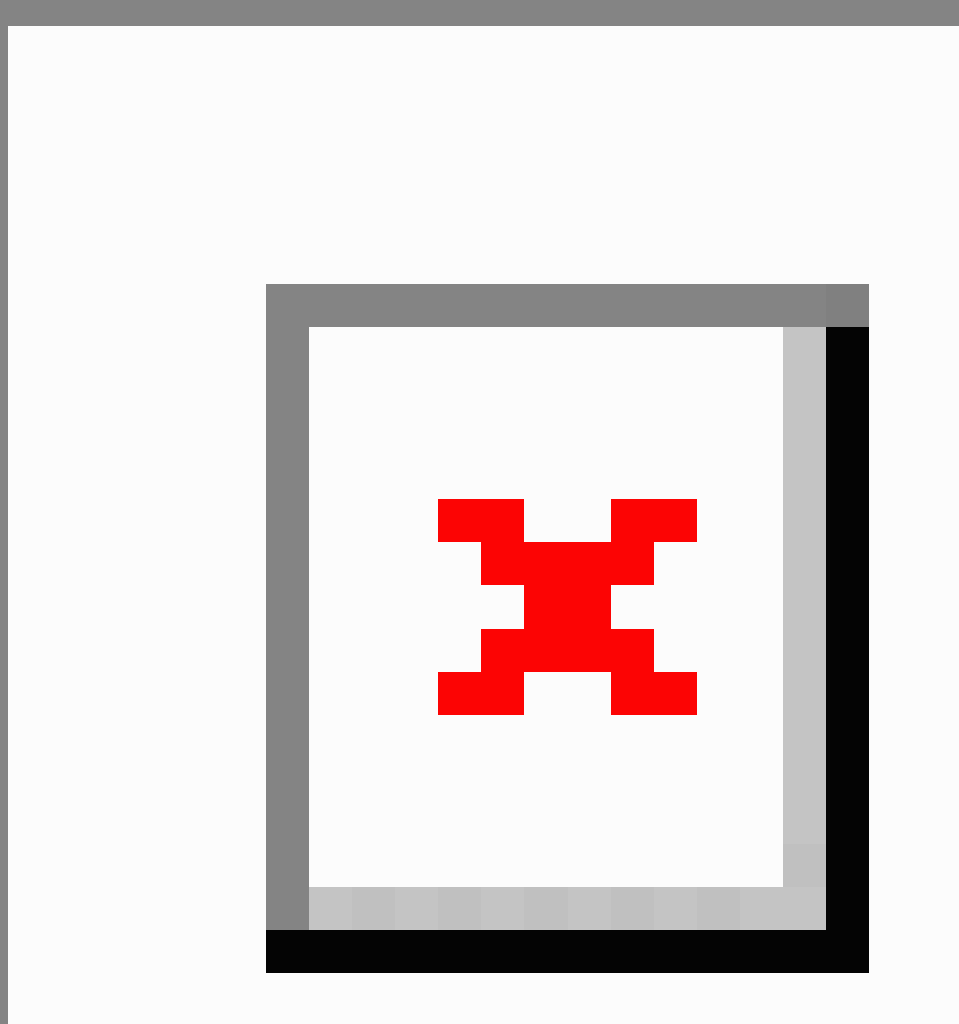
Figure 4. Nonusage attrition curves for open access users and trial participants over 18